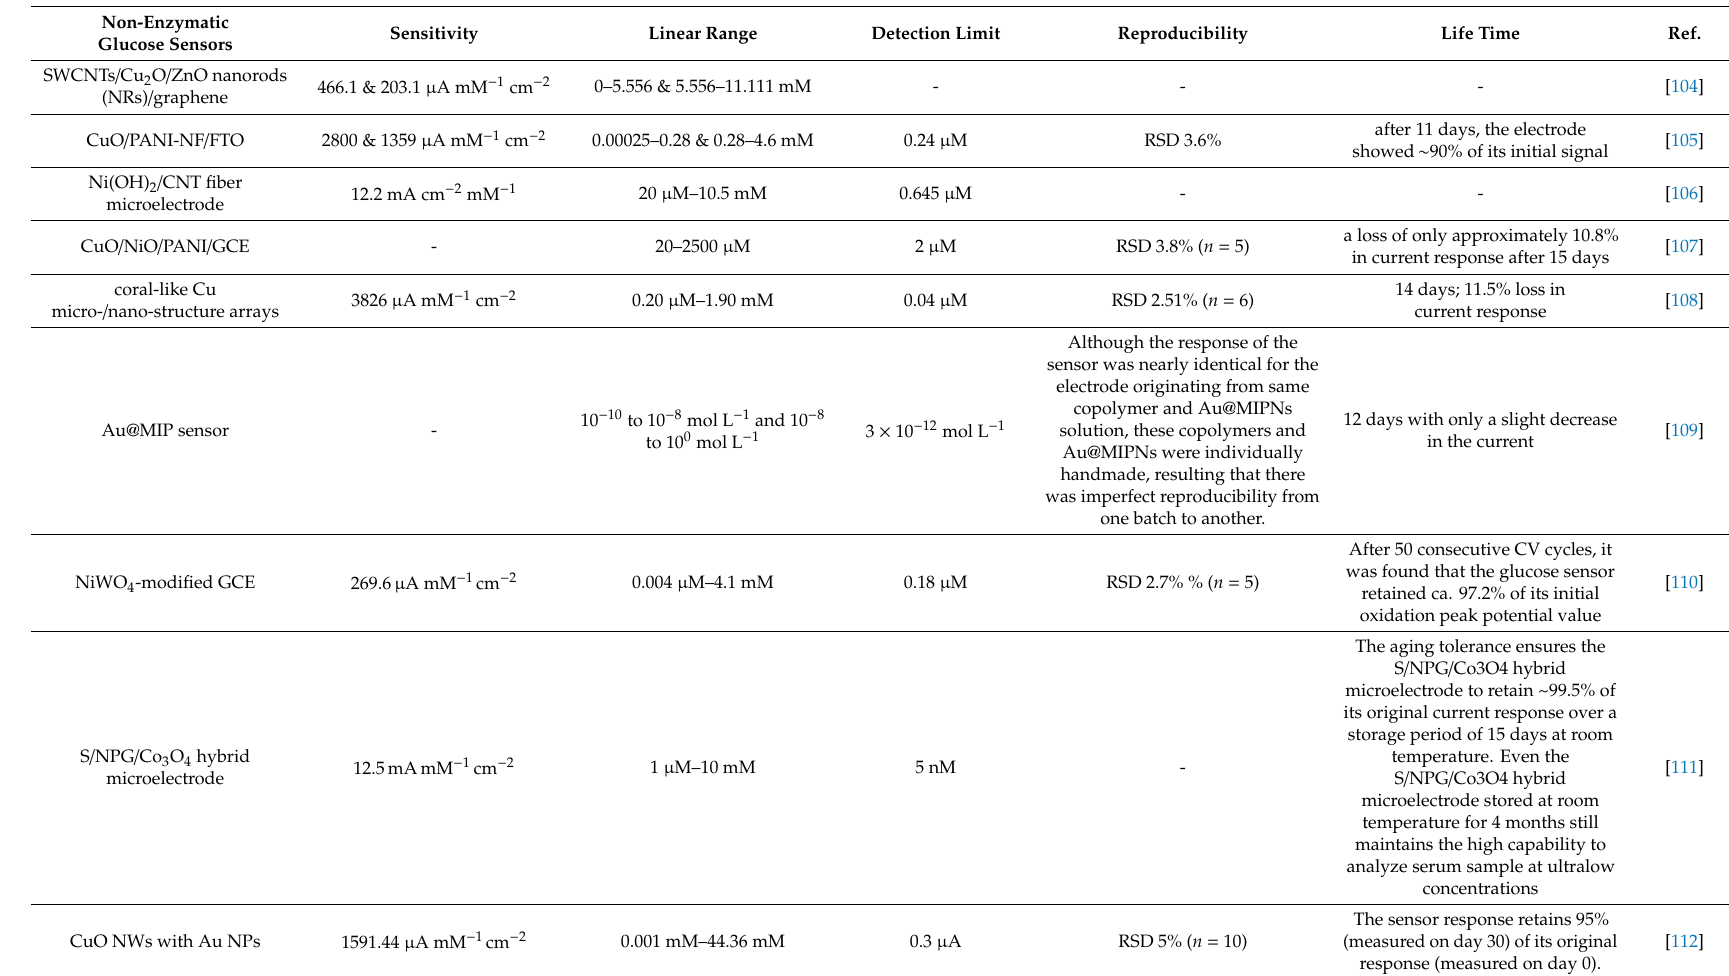
Table 2. Other nanostructures based non-enzymatic high-performance glucose